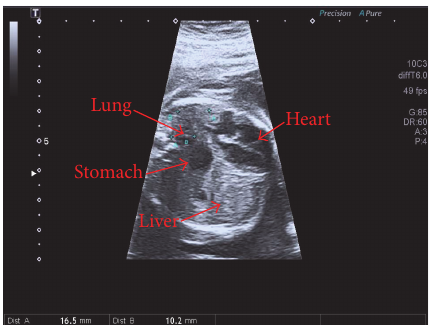
Figure 2: Karyotype of amniotic fluid cells showing additional material in the long arm of chromosome 11 (black arrow).